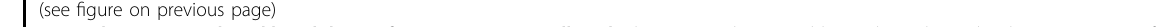
of 1500 cells/ fi sh), labelled with CellTrace ™ Far Red (Thermo Fisher Scienti fi c), was microinjected into the perivitelline space of the anesthetized fi sh.